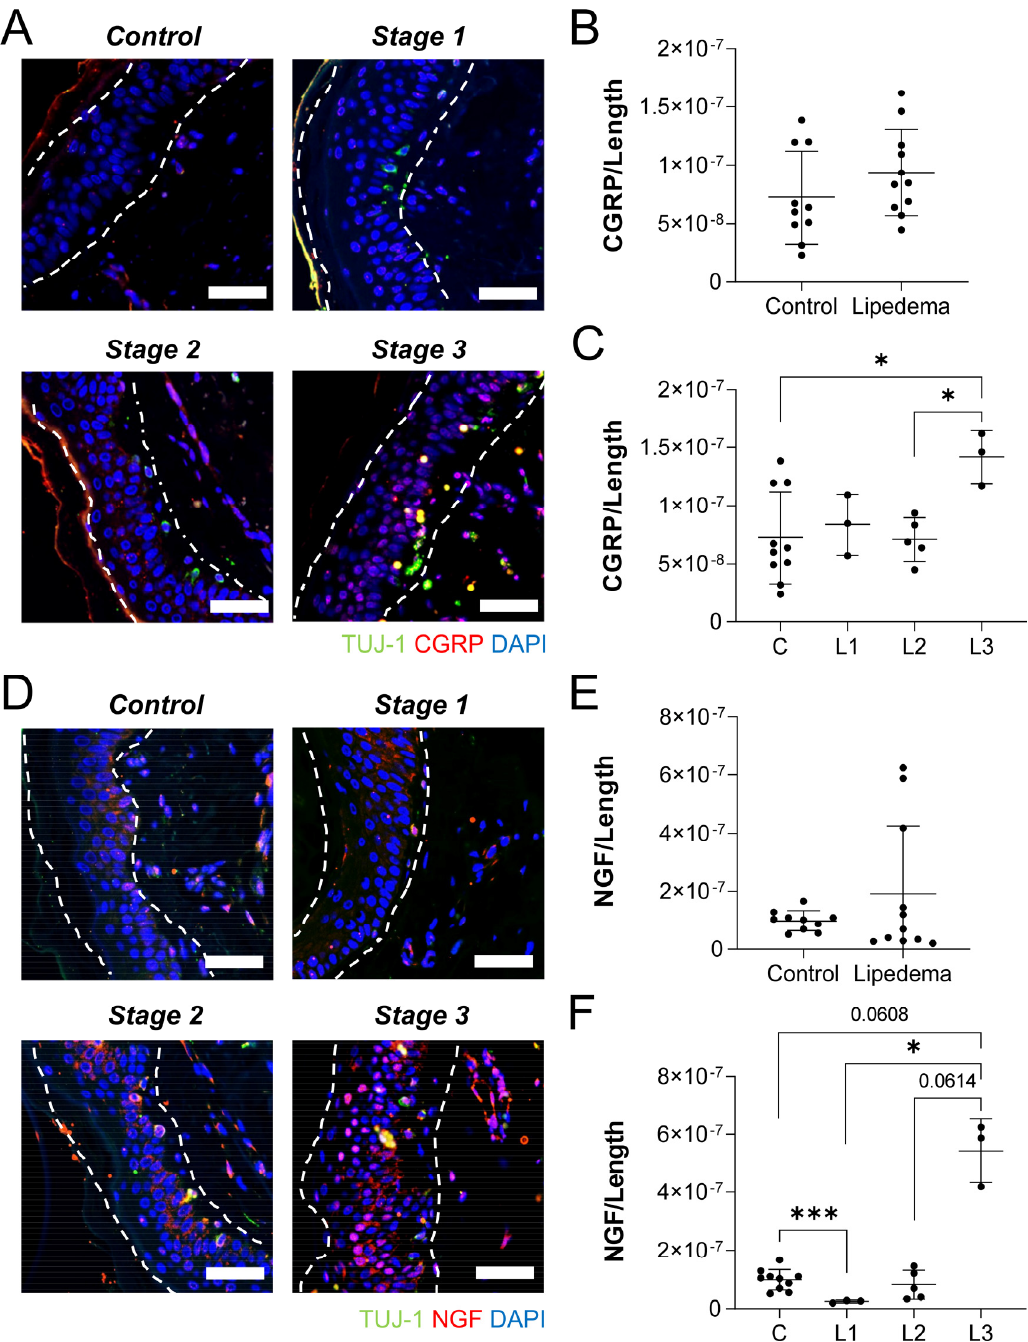
Figure 6. Lipedema stage-based characterization of neuropathic markers in thigh dermal sections. ( A ) Tuj1+ (green), CGRP (red), and nuclei (blue) in thigh dermis of stage 1, 2, and 3 lipedema. ( B ) CGRP fluorescence threshold normalized to the total length of the tissue in control and total lipedema patients. ( C ) CGRP fluorescence threshold normalized to the total length of the tissue in control and stage 1, 2, and 3 lipedema patients ( p = 0.0108 across stages by ANOVA). ( D ) Tuj1+ (green), NGF (red), and nuclei (blue) in thigh dermis of stage 1, 2, and 3 lipedema. ( E ) NGF fluorescence threshold normalized to the total length of the tissue in control and total lipedema patients. ( F ) NGF fluorescence threshold normalized to the total length of the tissue in control and stage 1, 2, and 3 lipedema patients ( p = 0.0054 across stages by ANOVA). ( A – F ) Control n = 10, Stage 1 n = 3, Stage 2 n = 5, Stage 3 n = 3. Bars = 100 µm. Mean ± SD. * p < 0.05 and ** p < 0.01 by post hoc multiple comparison test.